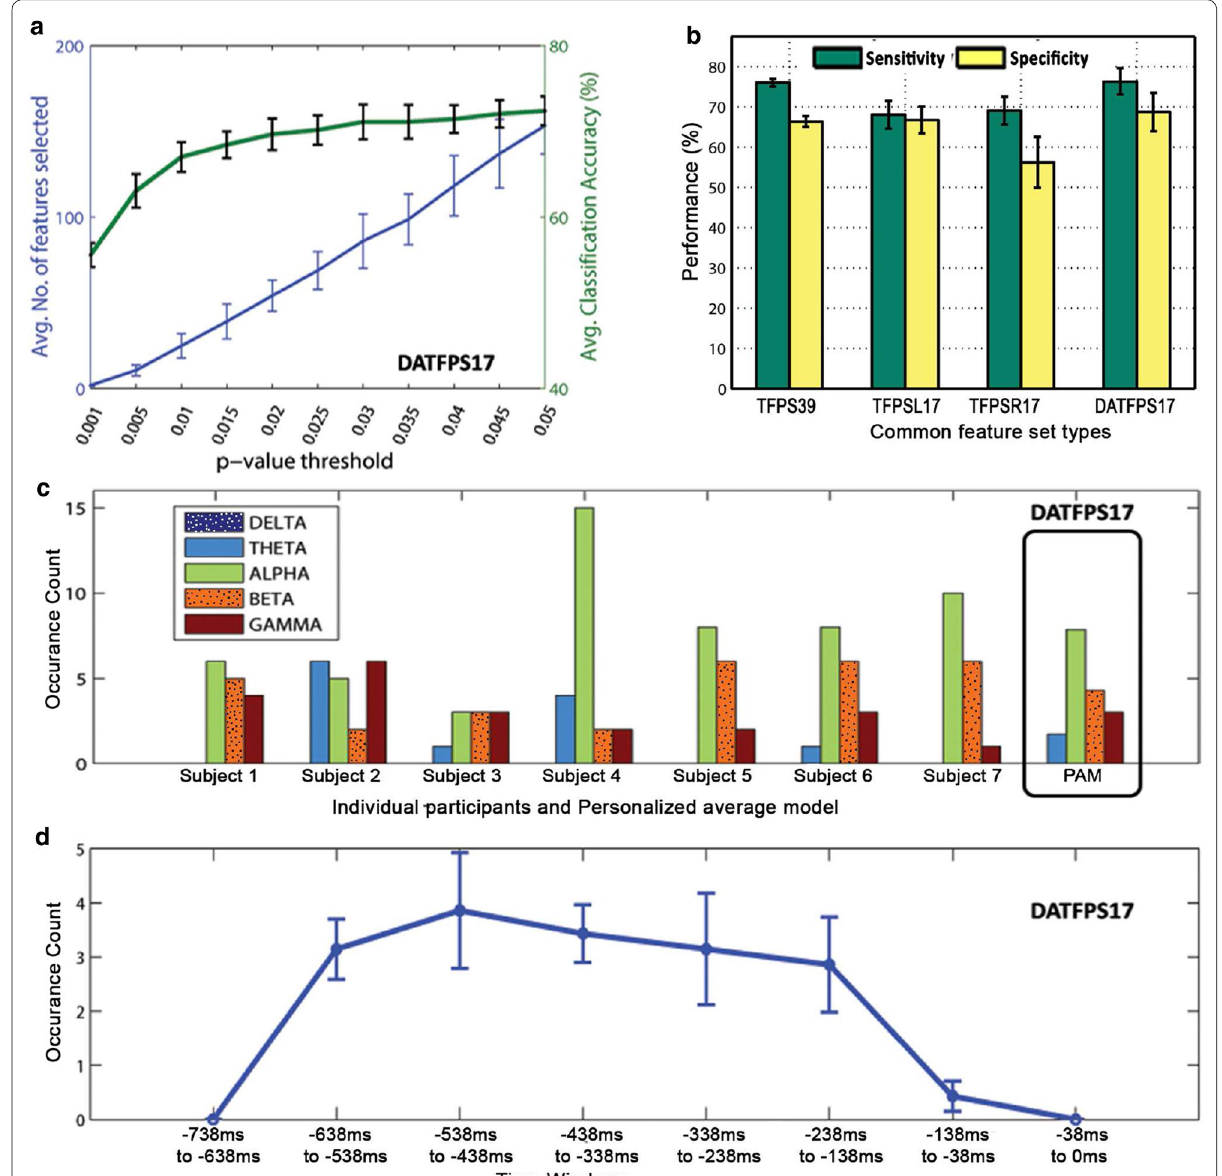
Fig. 8 Results of common feature set analysis: a Number of selected features and average classification accuracy are shown for hemispheric asymmetry features (DATFPS17) with respect to different p value thresholds as DATFPS17 feature set yielded the best accuracy among all common feature sets. b Grouped sensitivity and specificity performance (in %) are shown in bar plots with error bars that indicate standard deviation (SE) along all subjects. c Presentation of occurrence count of dominant features. Band-wise dominant features for each subject is shown for DATFPS17 features type. Among five EEG frequency bands, maximum selected features belonged from alpha frequency band. d Temporal course of occurrence count of dominant features. Error bars indicate SEM along all